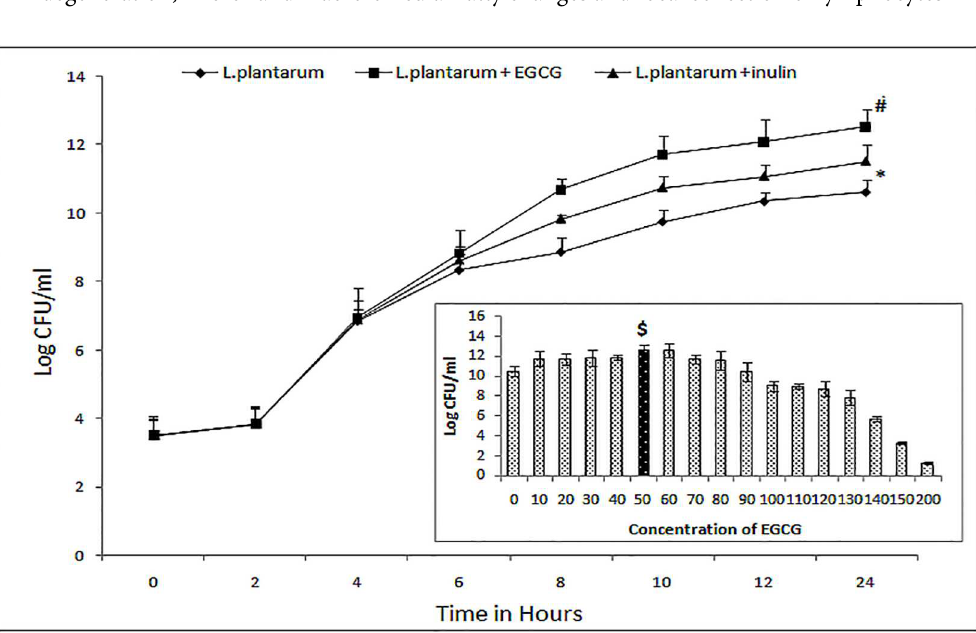
after 24 hour in the presenceof